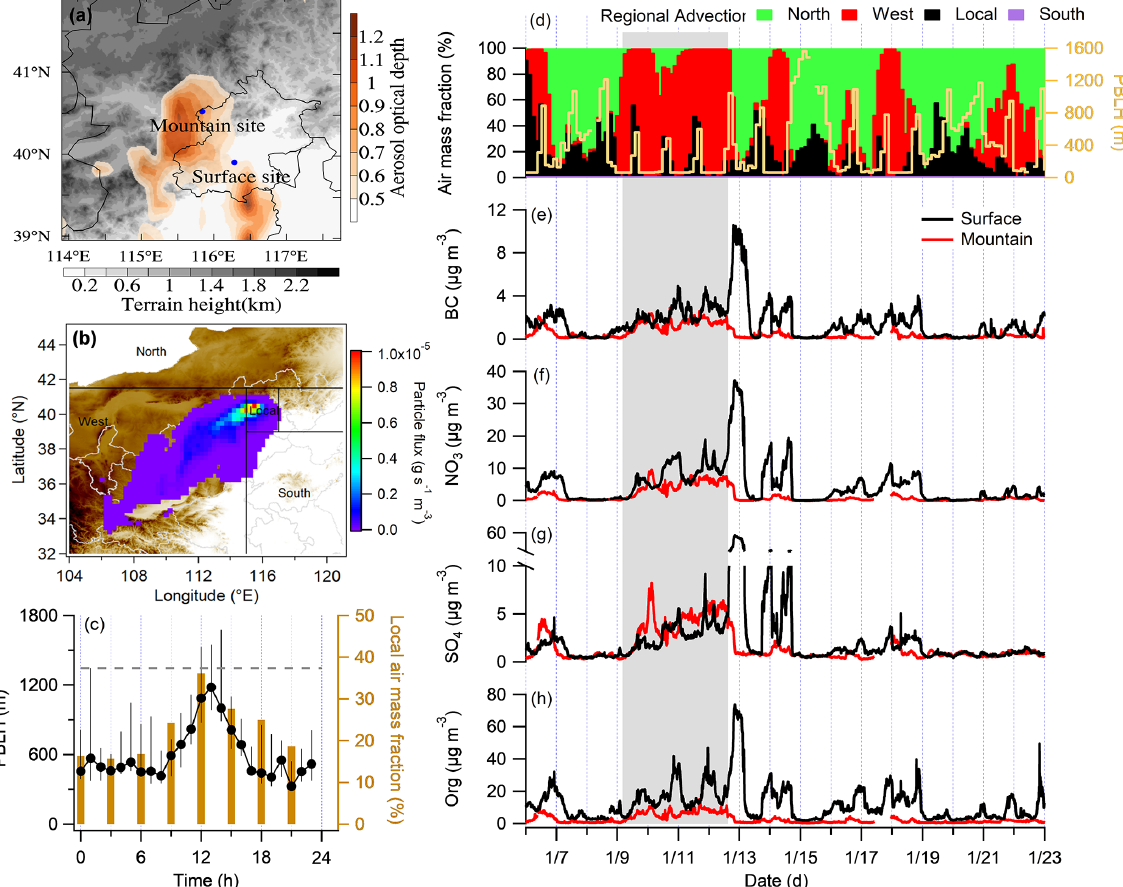
Figure 1. Experimental overview. (a) Spatial distribution of mean aerosol optical depth for the experimental month, with locations of surface and mountain sites, colored by terrain height. (b) A typical example of westerly dominated air mass from the Numerical Atmospheric– dispersion Modelling Environment (NAME) dispersion model outputs. (c) Diurnal cycles of the planetary boundary layer height (PBLH) and local air mass fraction contributing to the mountain site during the experimental period, with whiskers showing the 25th and 75th percentiles, and the dashed line denoting the altitude of the mountain site. (d) Time series of air mass fractions at the mountain and PBLH. (e–h) Time series of black carbon (BC), nitrate (NO 3 ), sulfate (SO 4 ), and organics (Org), with the black and red lines showing the surface and mountain site,